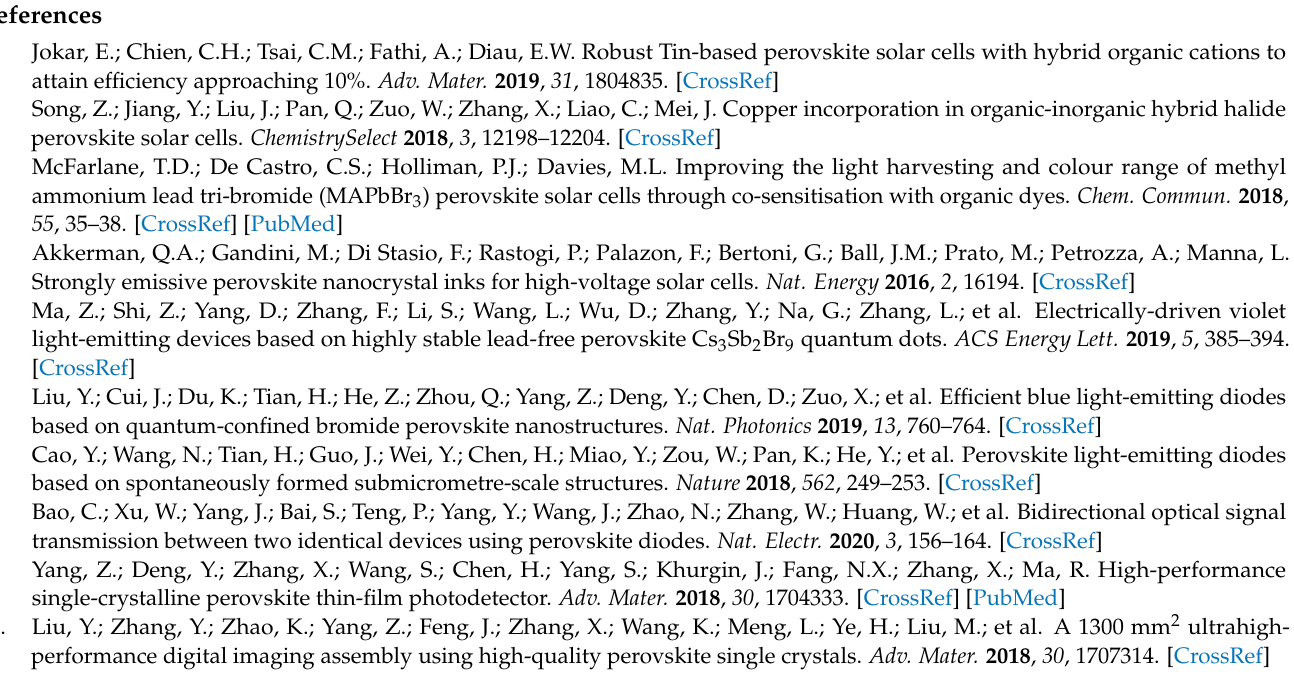
PEAI concentrations. Figure S2: Average grain size (a) and coverage (b) of perovskite with different PEAI concentrations. Figure S3: Correlation of grain aspect ratio and PEAI concentration. Figure S4: (a) The wavelength and intensity of the MAPbBr 3 emission peak at different PEAI concentrations. (b) Perovskite bandgap energy at different PEAI concentrations. Figure S5: Schematic diagram of perovskite growth in precursor solution containing PEAI at different stages. Figure S6: (a–f) Microscopic image of perovskite films with different standing times (the samples are only spin-coated for 5 s). (g) Microscopic image of the perovskite film prepared by spin-coating for 60 s. The scale bar is 50 µ m. Table S1: Grain size of the perovskite at various PEAI